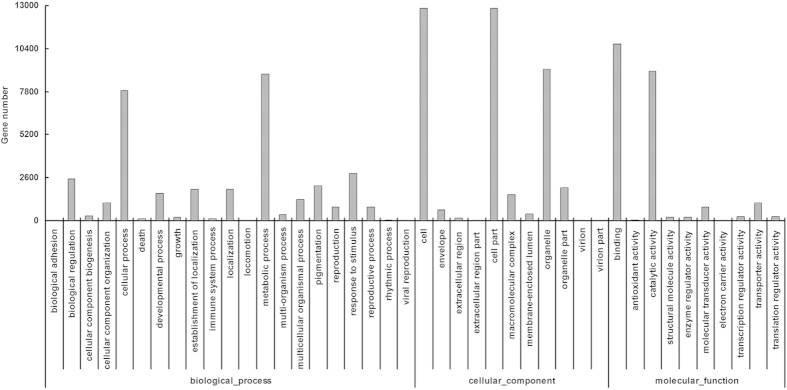
GO classifications of the assembled unigenes identified via transcriptome analysis of rubber tree bark.